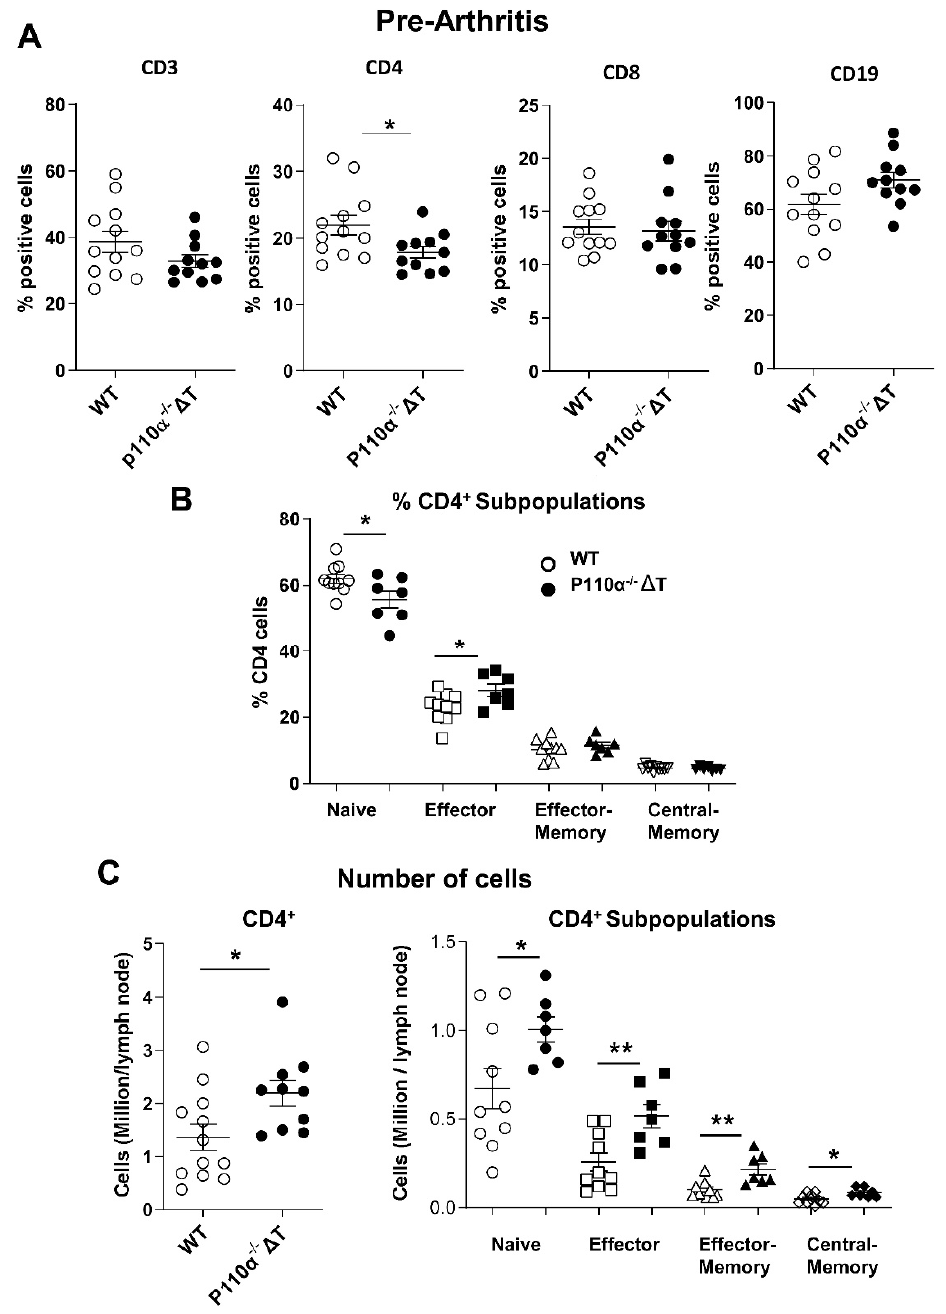
Figure 6. Analysis of T-cell subpopulations in the lymph nodes of p110 α − / − ∆ T mice before the onset of arthritis (13 days post-Ag administration). ( A ) Percentage of CD3 + , CD4 + , CD8 + and CD19 + lymphocytes in the draining lymph nodes of WT and p110 α − / − ∆ T mice, as indicated. ( B ) Fraction of naive, effector and memory CD4 + T cells, based on CD62-L and CD44 expression. ( C ) The number of CD4 + cells (millions per draining lymph node, left) or the number of naive/effector/memory CD4 + cells per lymph node (right) in immunized WT and p110 α − / − ∆ T mice were determined. Mice were individually analyzed; n = 12 for WT and n = 10 for p110 α − / − ∆ T mice. For naive/effector/memory subpopulation analysis, n was 10 for WT and 7 for p110 α − / − ∆ T mice. Open symbols, WT mice; closed symbols, p110 α − / − ∆ T mice. * p < 0.05; ** p < 0.01. Data show the mean ± SEM from individual mice.